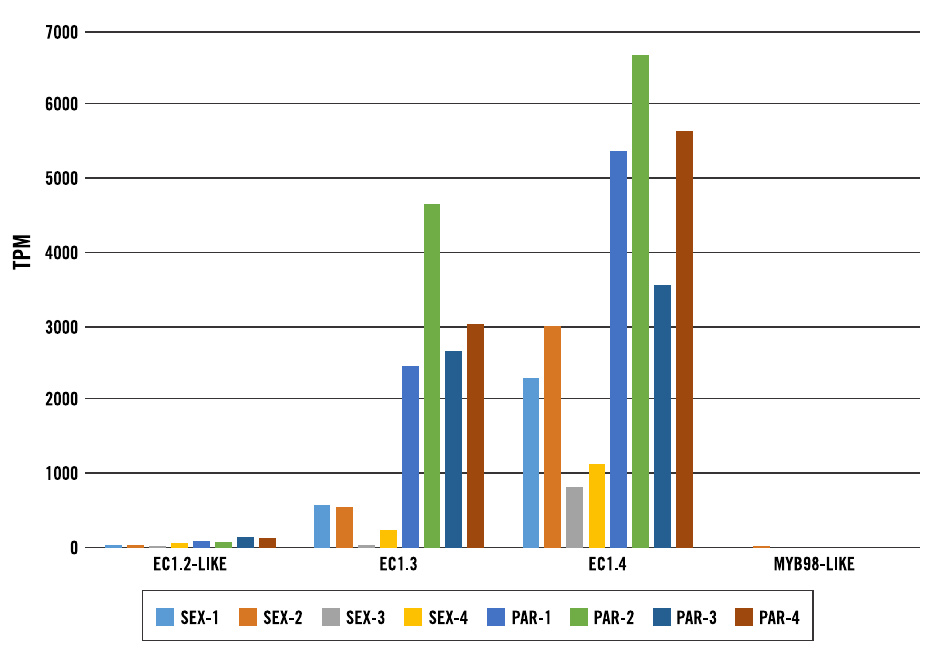
Figure 2. Cell type-specific gene expression plot. This plot is based on TPM of sexual (SEX) and parthenogenetic (PAR) LCM egg read